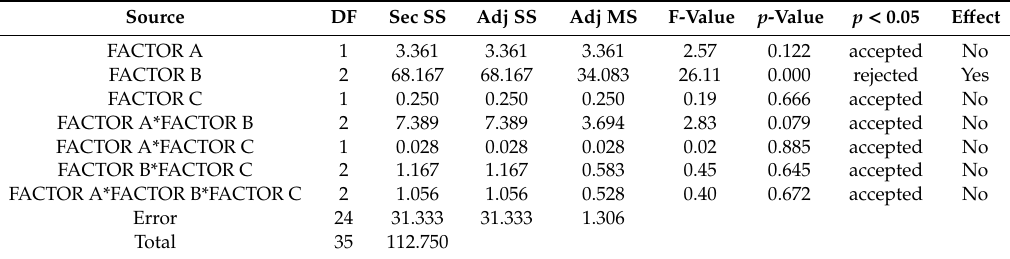
Table 5. ANOVA study results. A p -value < 0.05 means that the factor or interaction has a significant e ff ect on the output variable. Only Factor B complies with p -value < 0.05 corresponding to the type of SD card